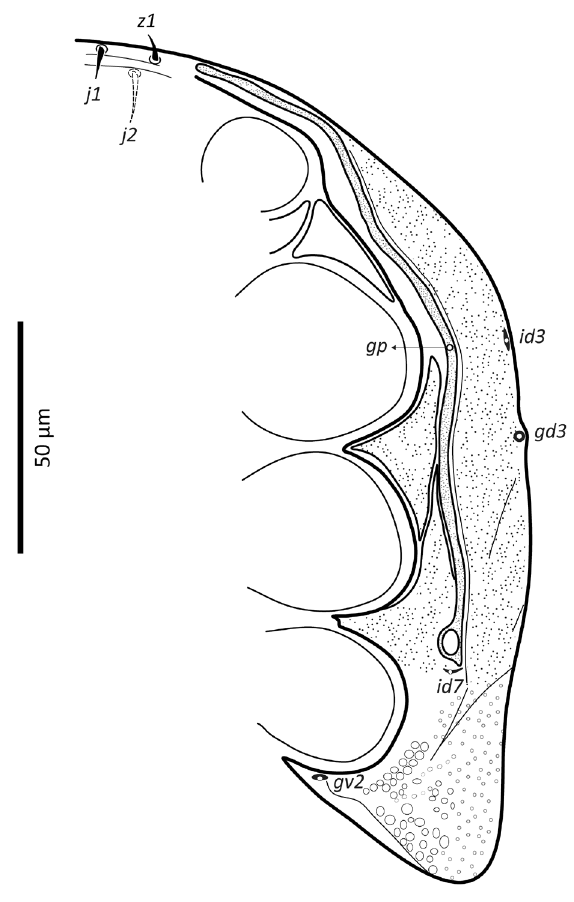
Figure 5. Zygoseius papaver sp. n., female, peritrematal shield. extending well behind posterior level of coxae IV. Shield essentially micropunctate throughout, with larger punctae in poststigmatic region, bearing four pore-like struc- tures ( id3 , gd3 , id7 ), including gv2 . Exopodal element between coxae II–III insensibly separated from posterior portion of more posterior exopodal-peritrematal elements (Fig. 5). Soft lateral and opisthogastric integument finely plicate, bearing nine pairs of short smooth setae, 11–20 long, most of which slightly thickened basally; soft cuticle with five pairs of poroids (4 ivo , idR3 ), and one subcircular platelet bearing two pore- like structures (putatively a gland pore, and an associated poroid), near posterolateral margin of peritrematal-metapodal